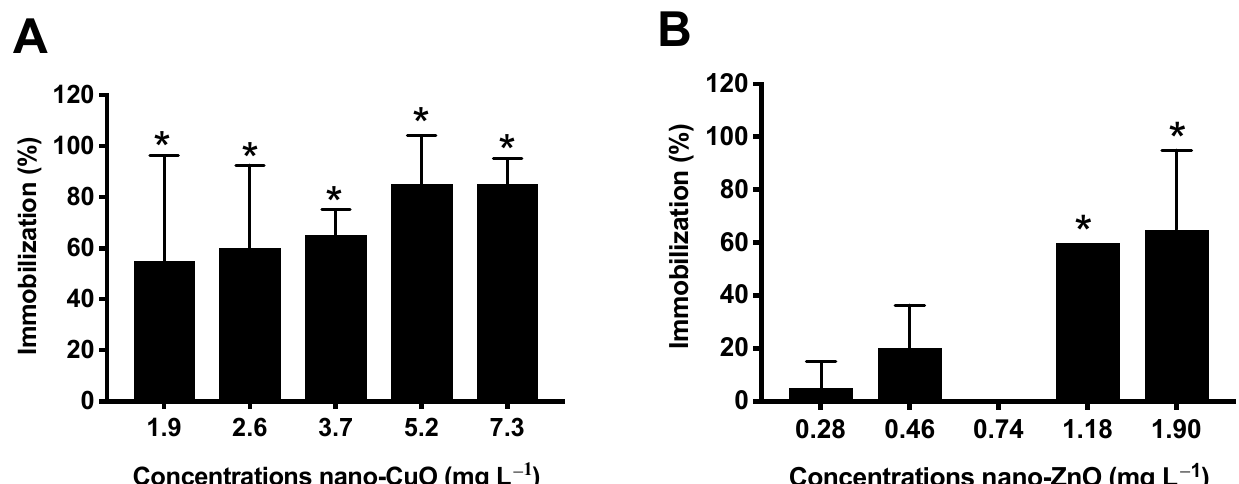
Figure 3. Percentage of D. magna immobilization exposed to nano-CuO ( A ) and nano- ZnO ( B ) suspensions for 48 h. Values are reported as the mean of four replicates ± standard deviation (ANOVA followed by Dunnett´s test, * p < 0.05 compared to control). Along the toxicity assays, the neonatal immobilization percentage in the control group was 0%.